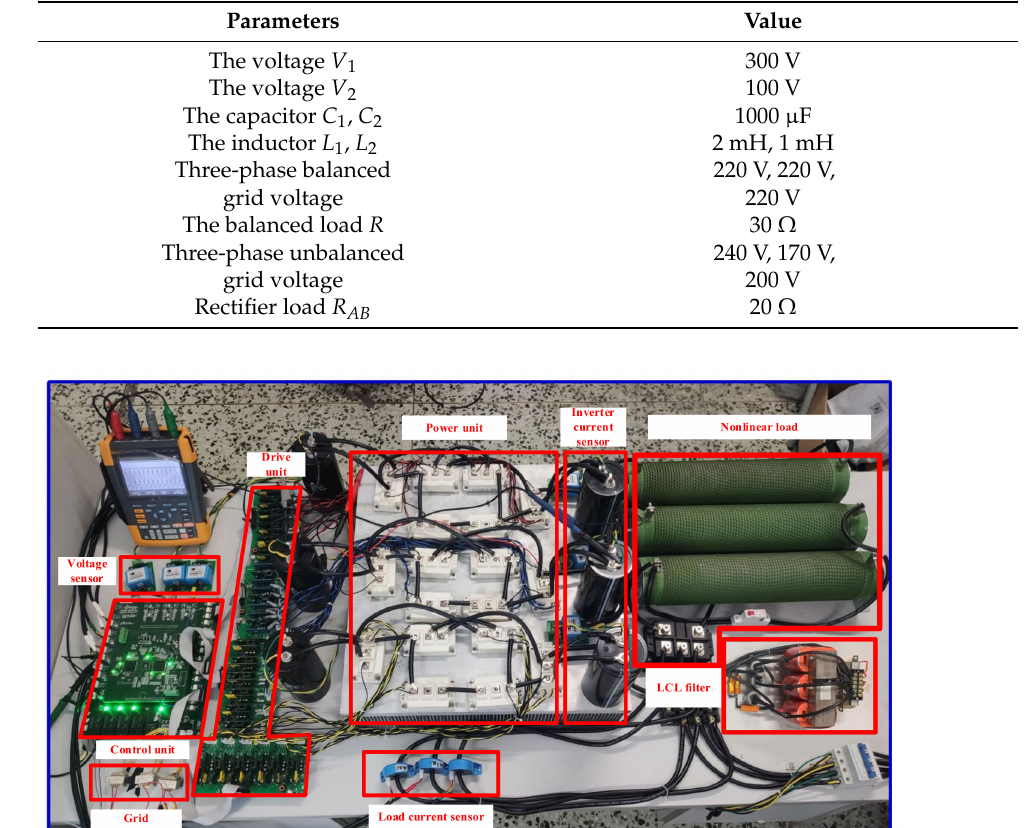
Table 5. Key parameters.